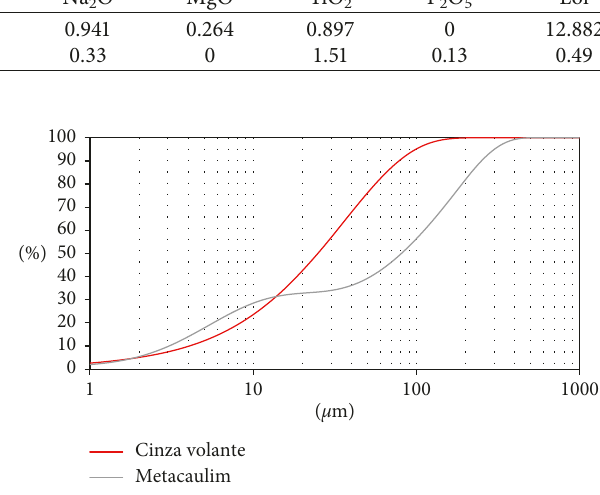
Figure 2: Distribution of the size particles for fly ash and metakaolin.